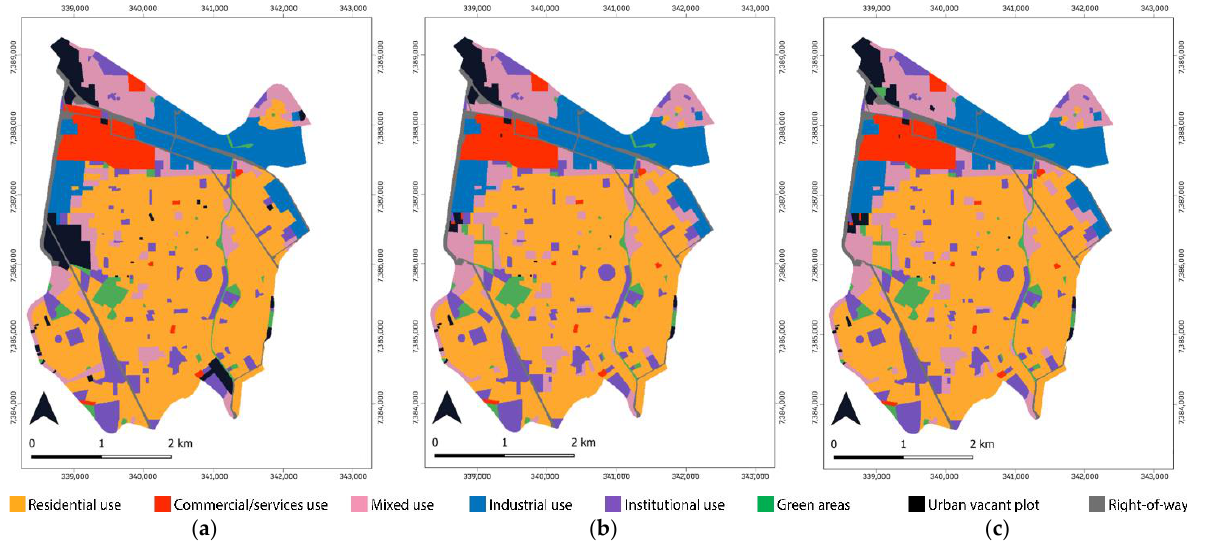
Figure 11. Land use maps of São Caetano do Sul: ( a ) 2006, ( b ) 2018, ( c ) 2021.